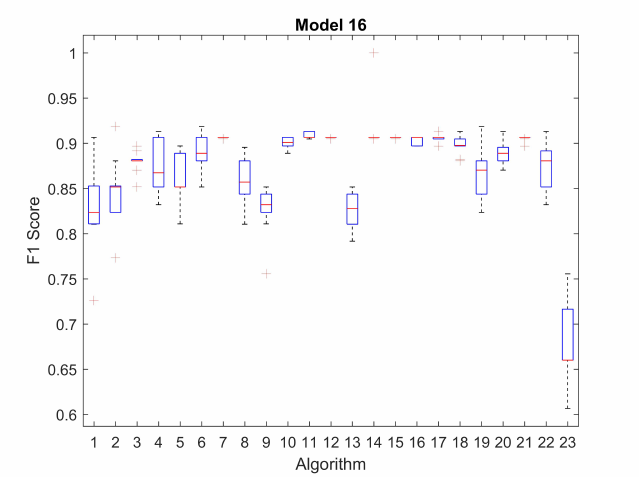
Figure A15. F1-score of Model 16 for the different algorithms. The 23 algorithms are represented in the x -axis, and the accuracy is shown in the y